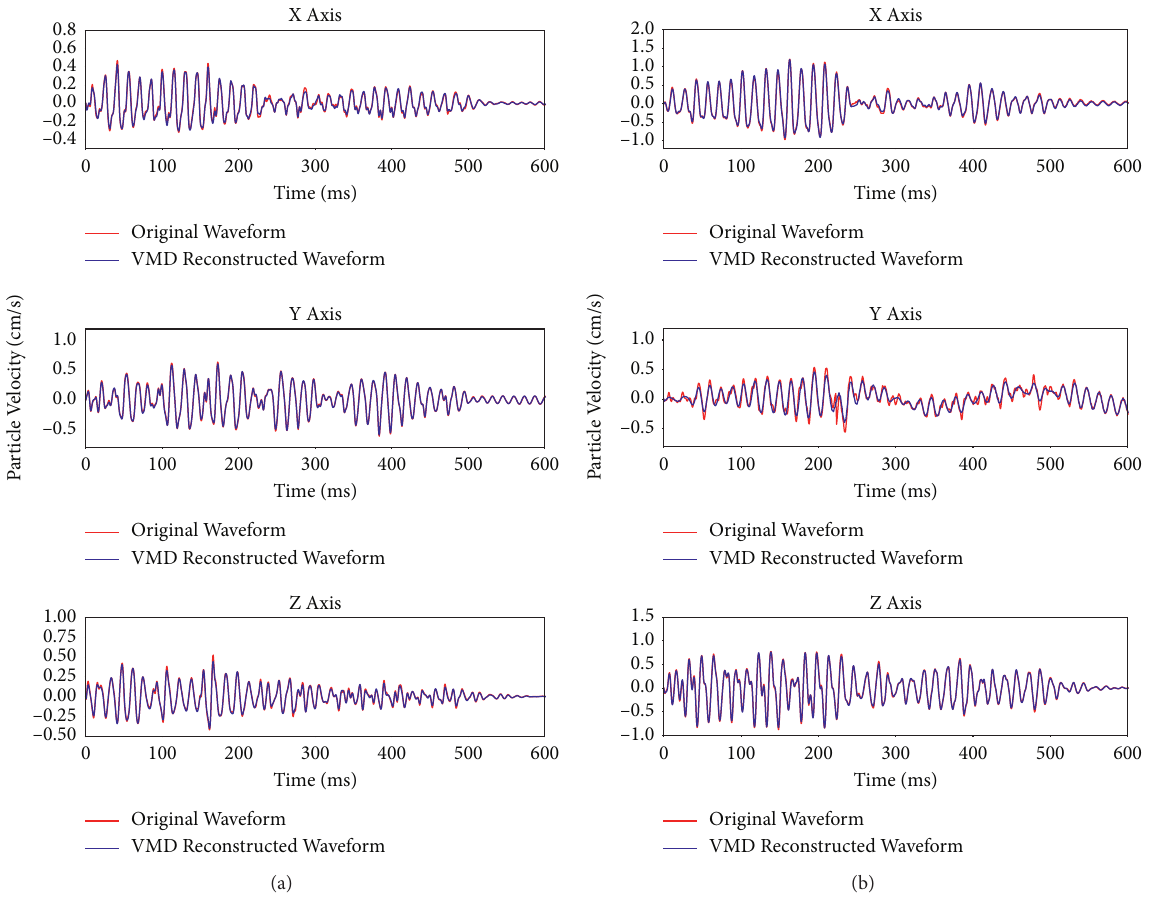
Figure 10: Typical time history curves of original waveform and reconstructed waveform: (a) monitoring point 2 at +10m; (b) monitoring point 5 at − 10 m.